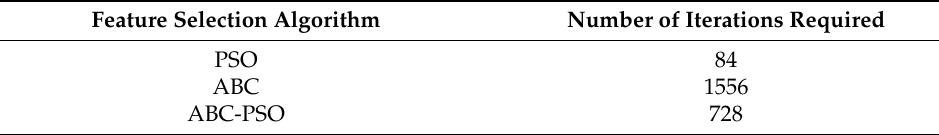
Figure 5. Comparison of the convergence rate of different feature selection algorithms. Table 8. Comparison of the convergence rate of nine optimal selected features.